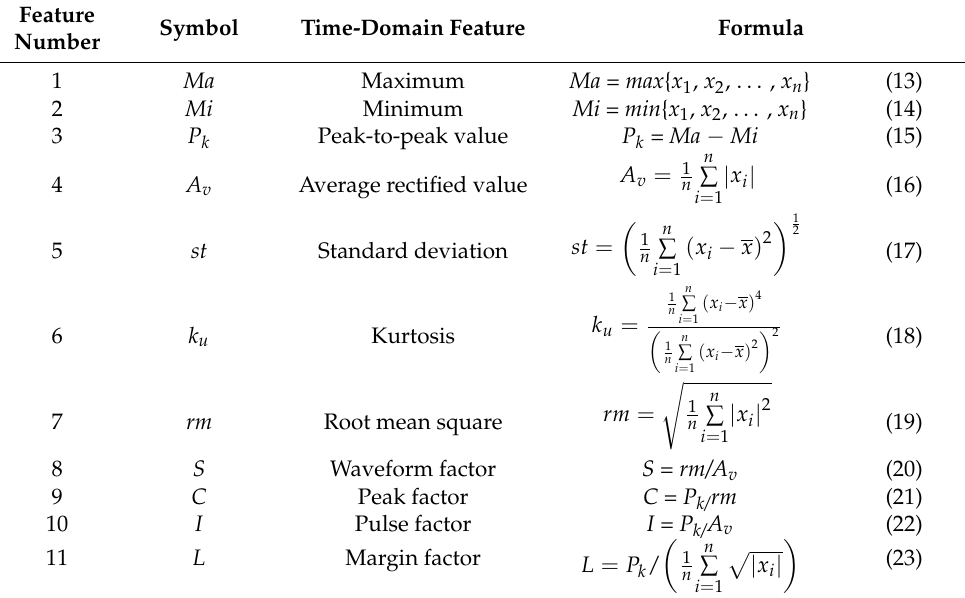
Figure 7. Wavelet packet decomposition of raw vibration signal. Table 5. Time-domain characteristics of rolling bearings.